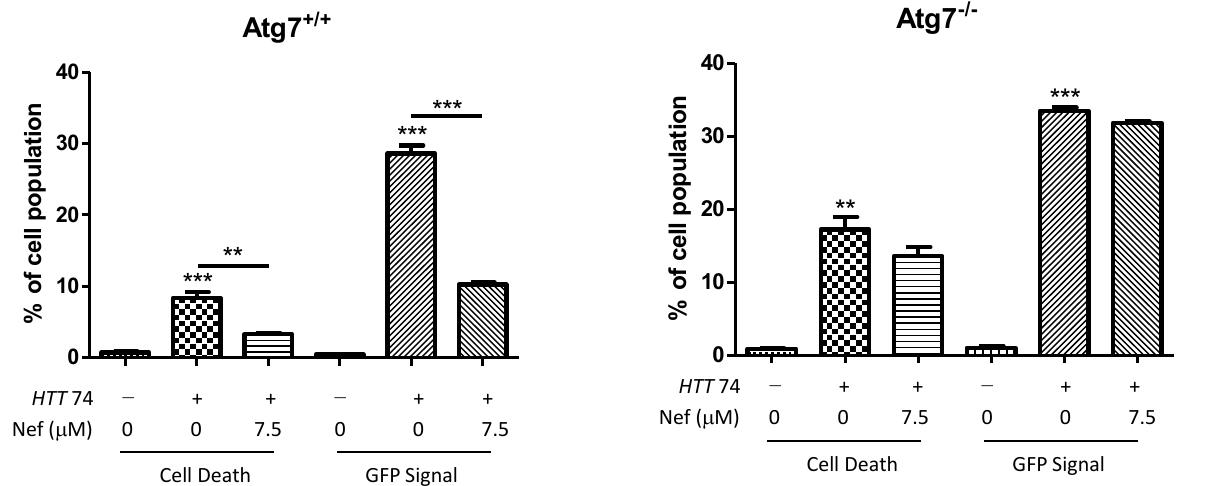
Figure 5. Neferine reduces the toxicity of mutant huntingtin in cells. ( A ) PC-12 cells transfected with huntingtin with 74 CAG repeats for 16 h were treated with neferine for a further 24 h. Cell viability was then measured by the MTT assay or ( B ) by counting the number of viable cells after treatments. A significantly higher percentage of cell viability was detected after neferine treatments. ( C ) Wild-type Atg7 and Atg7-deficient MEF cells transfected with huntingtin with 74 CAG repeats (EGFP- HTT 74) for 6 h were treated with neferine for a further 48 h. A significant lower percentage of cells with positive propidium iodide staining (cell death) and GFP signals was detected in wild-type Atg7 cells after neferine treatments. Data from the bar chart represent the means ± SD of three independent experiments. * p < 0.05; ** p < 0.01; *** p <